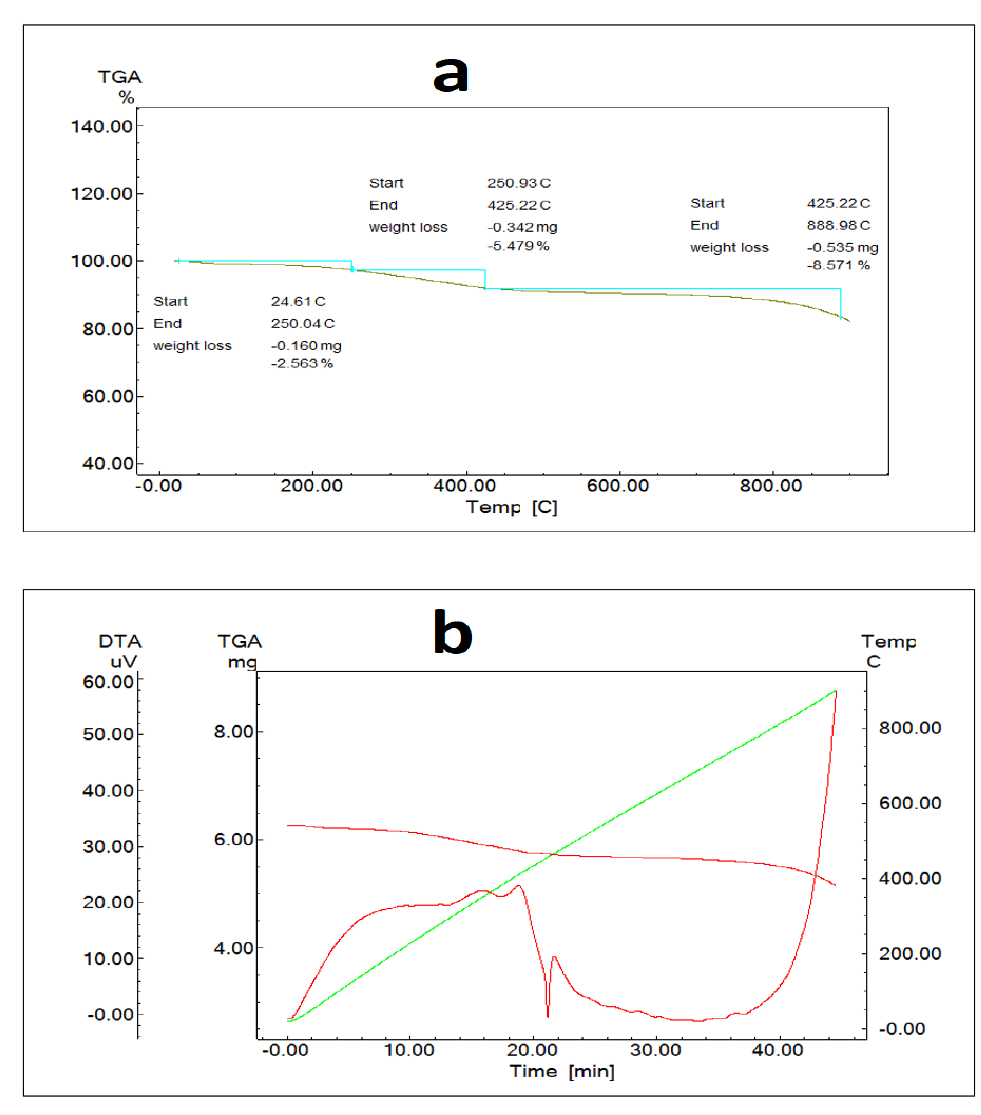
Figure 8. The findings of TG and DT analyses reveal that biosynthesized AgNPs were stable and durable at high temperatures ( a , b ).